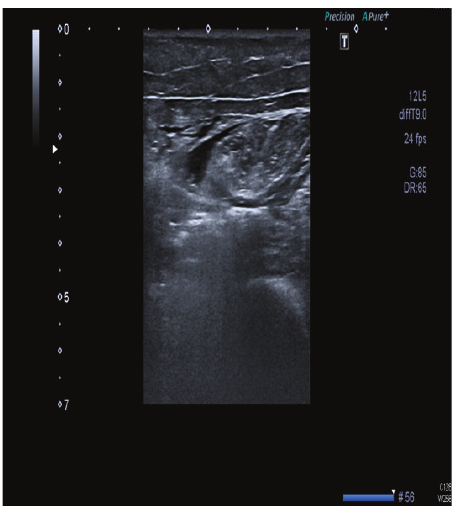
Figure 1: Ultrasound of thigh: edema and fluid bands around anterior thigh muscles.